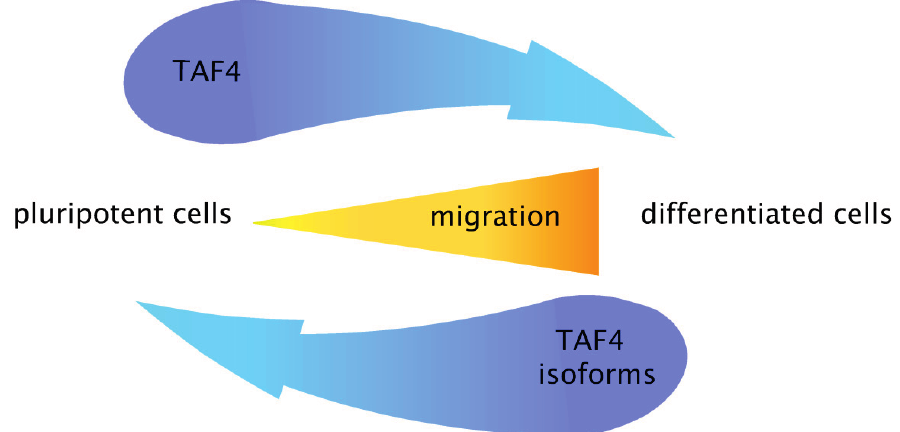
Figure 3. A model describing the cross-talk between canonical TAF4 and its alternative isoforms in pluripotent (stem cells) and differentiated cells, and their relation to migration. High levels of canonical TAF4 (blue arrow from left to right) are a characteristic to normal stem cells and cancer cells. In contrast, differentiated cells maintain high expression of TAF4 isoforms with deletions in hTAF4–TAFH domain (blue arrow from right to left). Functional balance between canonical and alternative isoforms of TAF4 is crucial for cell migration. Consistent with this, cells with low expression of canonical TAF4 are prone to migration contrasting with low motility of cells with high levels of TAF4